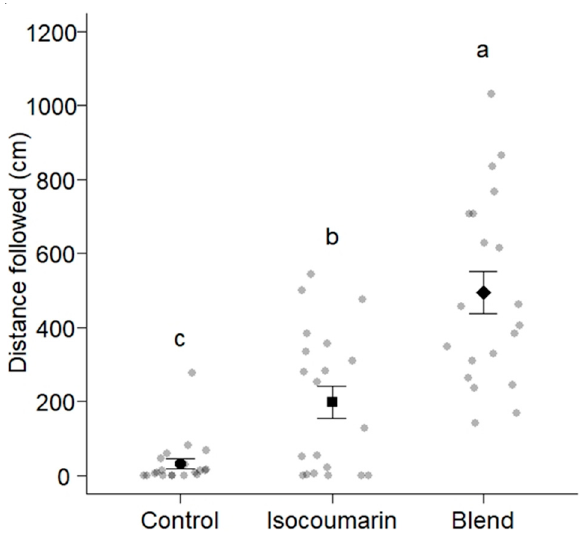
Figure 3. Distances worker ants of Lasius niger (n = 60) travelled following trails of synthetic 3,4-dihydro-8-hydroxy-3,5,7-trimethylisocoumarin (the known trail pheromone of La. niger [17]), a six-trail pheromone blend (Table 1), and a solvent control applied to the circumference of a circular filter paper (diam: 90 mm) marked in 1-cm intervals (Figure 1). Grey and black symbols show the distance that each ant and 20 ants on average (mean ± whiskers), respectively, travelled following trails. Means associated with different letters are statistically different (Tukey’s honest significant difference (HSD) test, p < 0.01); six out of 66 ants tested did not enter the bioassay arena and were excluded from this data set.